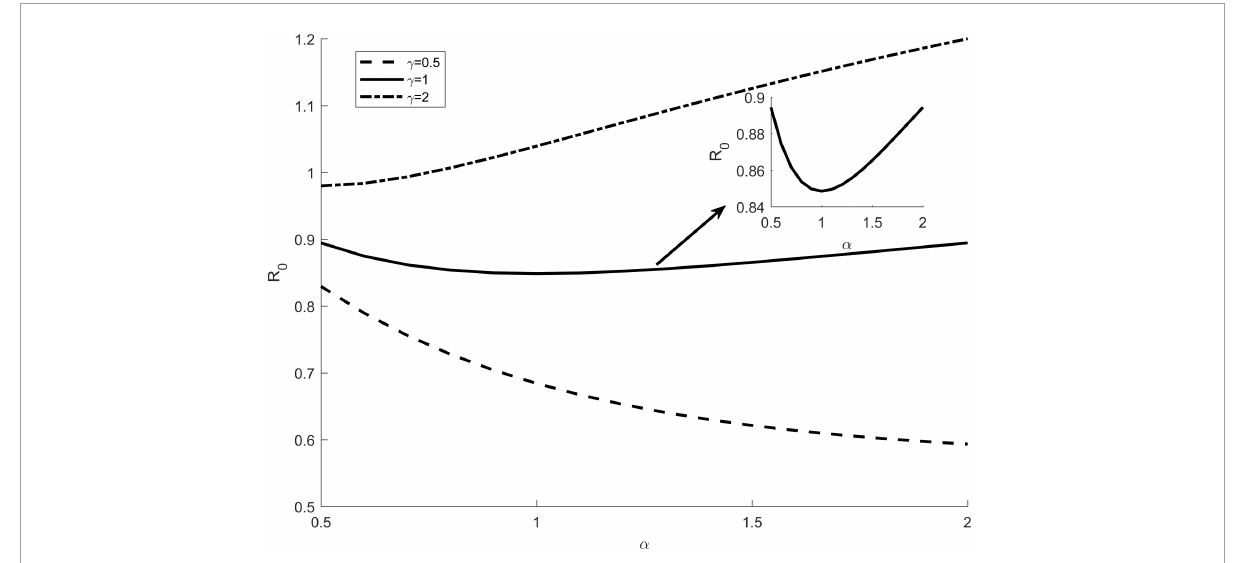
FIGURE3 The effect of vector preference α on R 0 without host interspecific competition. Different lines represent the results of different values of the transmission ratio γ . The inset of figure shows the case of γ = 1 when narrowing the vertical axis. The other parameters are: c 12 = c 21 = 0, b max = 0.3, K 1 = K 2 = 1000, K v = 4000, (cid:48) v = 0 . 1, g 2 = 0 .